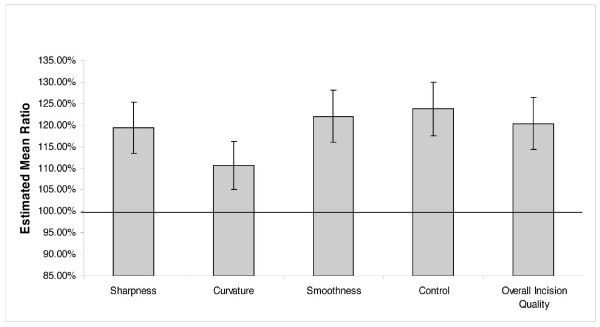
Silicon versus Steel. The estimated mean ratios and confidence intervals for each characteristic assessed for the silicon and steel knife comparison.